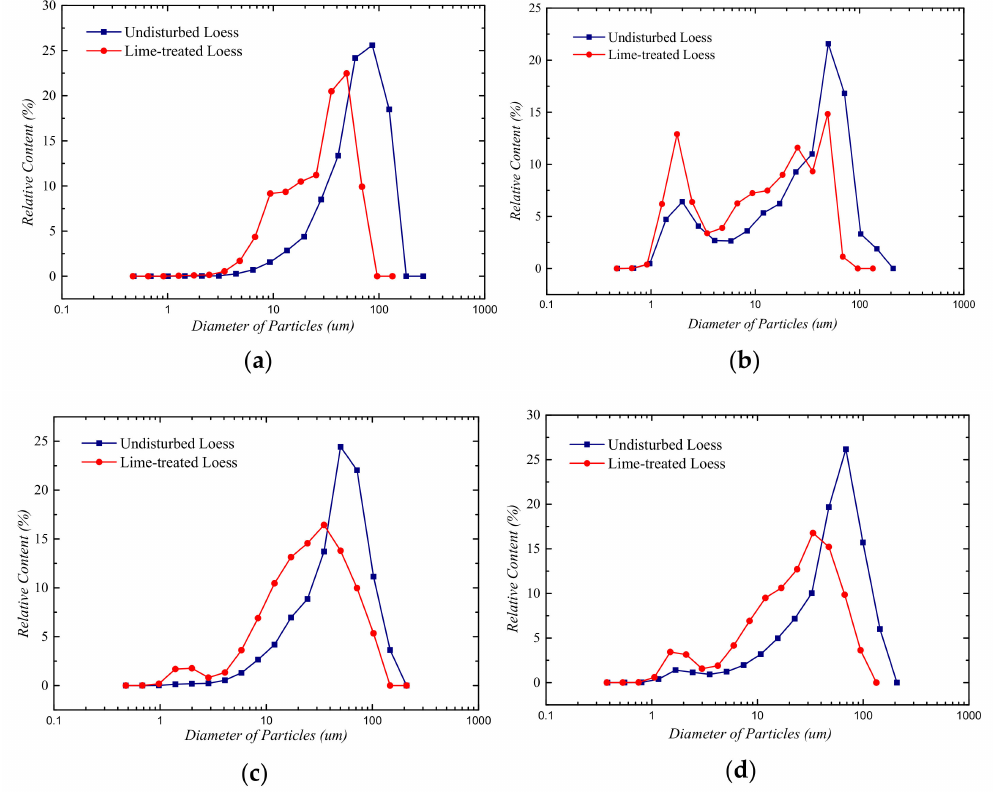
Figure 4. Particle size distribution curves of minerals in undisturbed loess and lime-treated loess. ( a ) Particle size distribution curve of quartz minerals; ( b ) particle size distribution curve of carbonate minerals; ( c ) particle size distribution curve of feldspar minerals; ( d ) particle size distribution curve of total